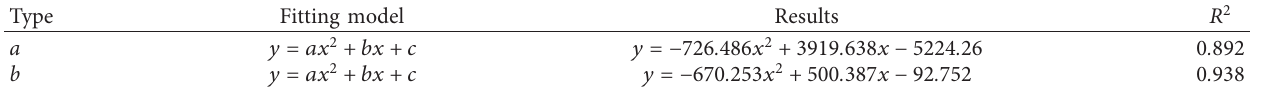
Figure 8: Graphs of D and strength. (a) Graph of D and compressive strength. (b) Graph of D and tensile strength. Table 16: Fitting results of mathematical expressions of D and